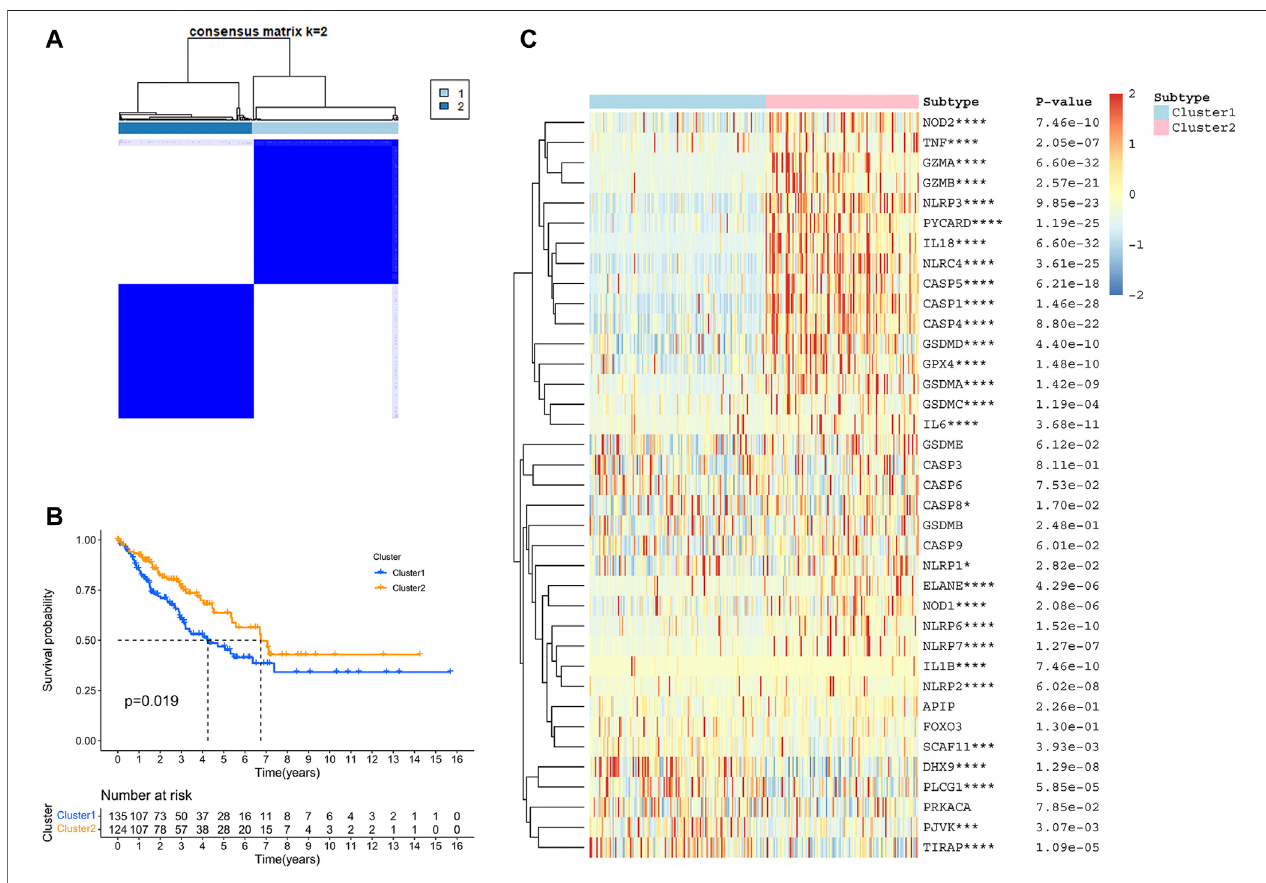
FIGURE 3 | Identi fi cation of TCGA-SARC cluster based on PRGs. (A) TCGA-SARC cohort was divided into two distinct clusters using pyroptosis-based consensus clustering analysis (k (cid:1) 2, repetition (cid:1) 1,000). (B) Overall survival (OS) curve comparing survival of patients in cluster 1 (blue) and cluster 2 (orange). (C) Heatmap of PRGs between two clusters (* p < 0.05, ** p < 0.01, *** p < 0.001, **** p <